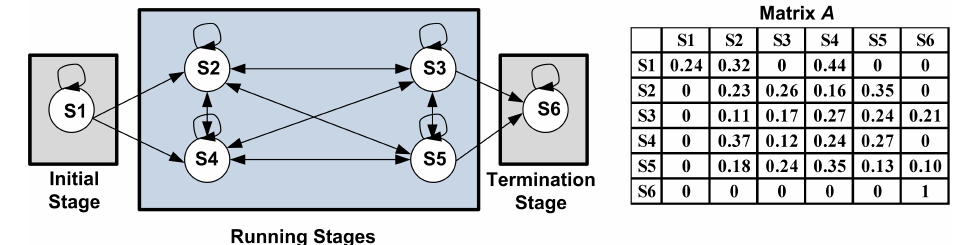
Figure 3. A six-state program behavior-aware HMM topology and its corresponding transition probability matrix A